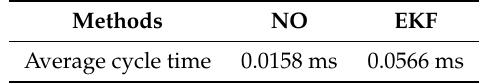
Table 7. The computational cost comparison of the proposed observer and